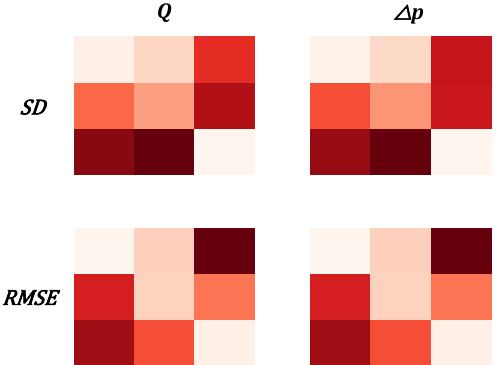
Figure 9. Illustrating the correlation between standard deviation and root mean squared error of the prediction. The left column of matrices shows the results for flow rate and the right column for pressure difference. The top row shows the matrices for standard deviation and the bottom row for RMSE. The matrices themselves show results for the 3 presented liquids thus far the 50,65,85 volume percentage water in the water–glycerol mixture. The diagonal values correspond to predictions 𝐸 (cid:3036)(cid:3037) , with i=j, while off ‐ diagonal values correspond to 𝐸 (cid:3036)(cid:3037) , with i ≠ j. It can be seen that in both RMSE and standard deviation (SD) the diagonal values are much smaller than the off ‐ diagonal values.